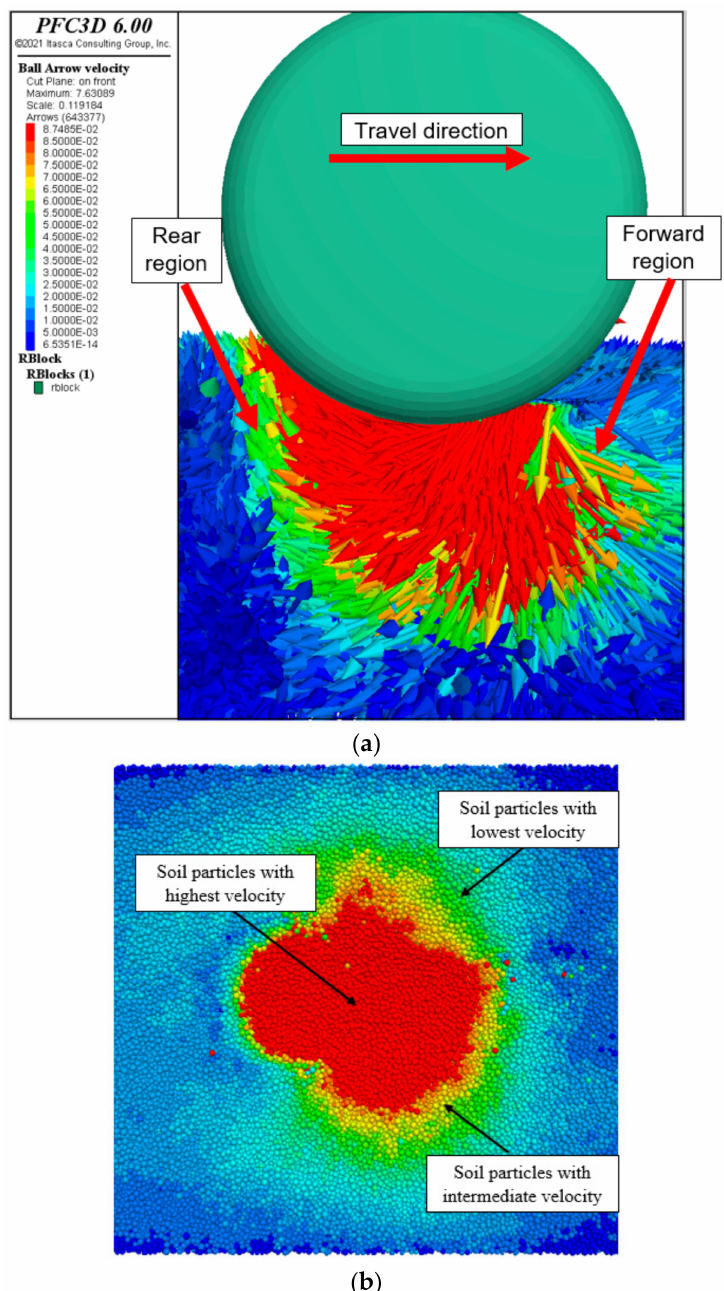
Figure 11. ( a ) Velocity flow distribution of soil particles during passage of press-wheel; ( b ) magnitude of velocity for soil particles directly beneath the press-wheel during passage (top view of